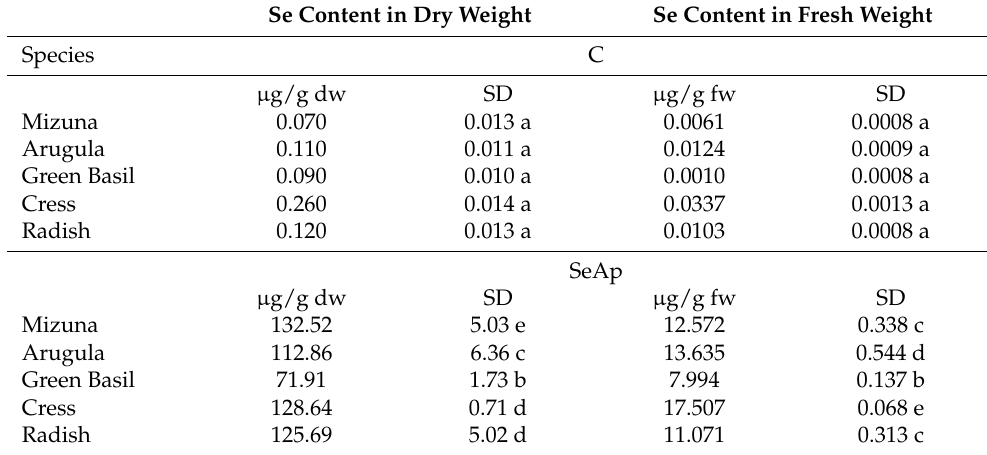
Table 5. Selenium content in microgreens species after fortification with sodium selenate. Se Content in Dry